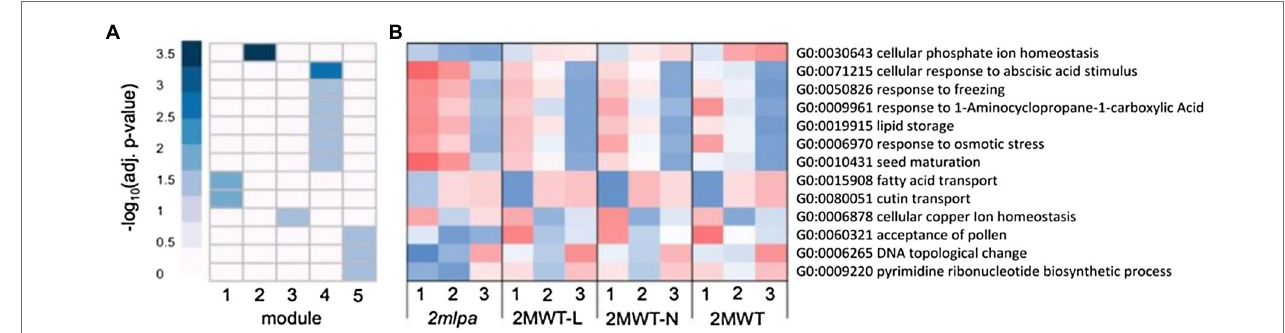
FIGURE 3 | Multidrug resistance-associated protein subset gene co-expression modules and significantly enriched biological processes. A module is defined as a group of genes sharing similar expression profiles over time and likely involved in the same biological processes. Rows represent hierarchical clustering of significantly enriched GO categories. Significantly enriched GO categories were defined as those with an FDR < 0.05 (A) Heatmap of significantly enriched GO biological processes in each gene co-expression module. Columns represent modules. Color represents − log 10 adjusted value of p . (B) Average scaled expression of genes in significantly enriched biological processes. Columns represent germination stages of 2mlpa , 2MWT-L, 2MWT-N, and 2MWT. Red color represents increased expression, and blue color represents decreased expression. Enrichment for all GO categories can be found in Supplementary Table S2